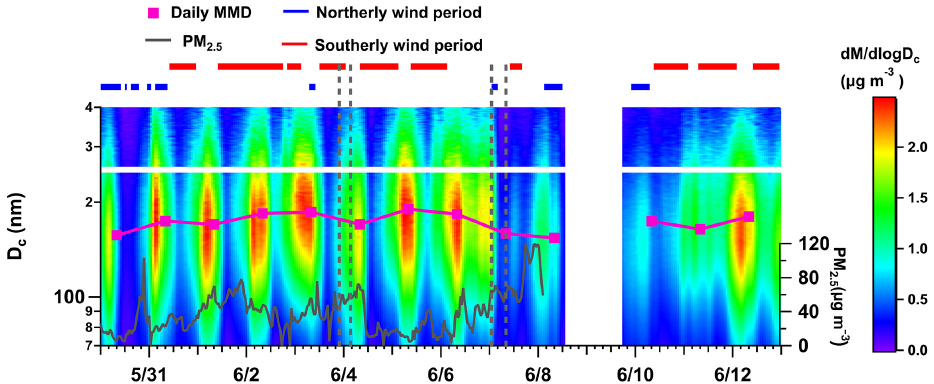
Figure 5. Time series of the mass size distribution of rBC. A southerly wind period is selected when the wind direction is 135–225 ◦ , and a northerly wind period is the time when the wind direction is 325–45 ◦ . The gray dashed line denotes the rainy period.